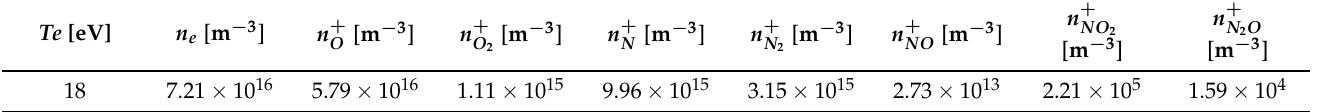
Table 2. Positive ion density and plasma temperature at breakeven for 250 km of orbital